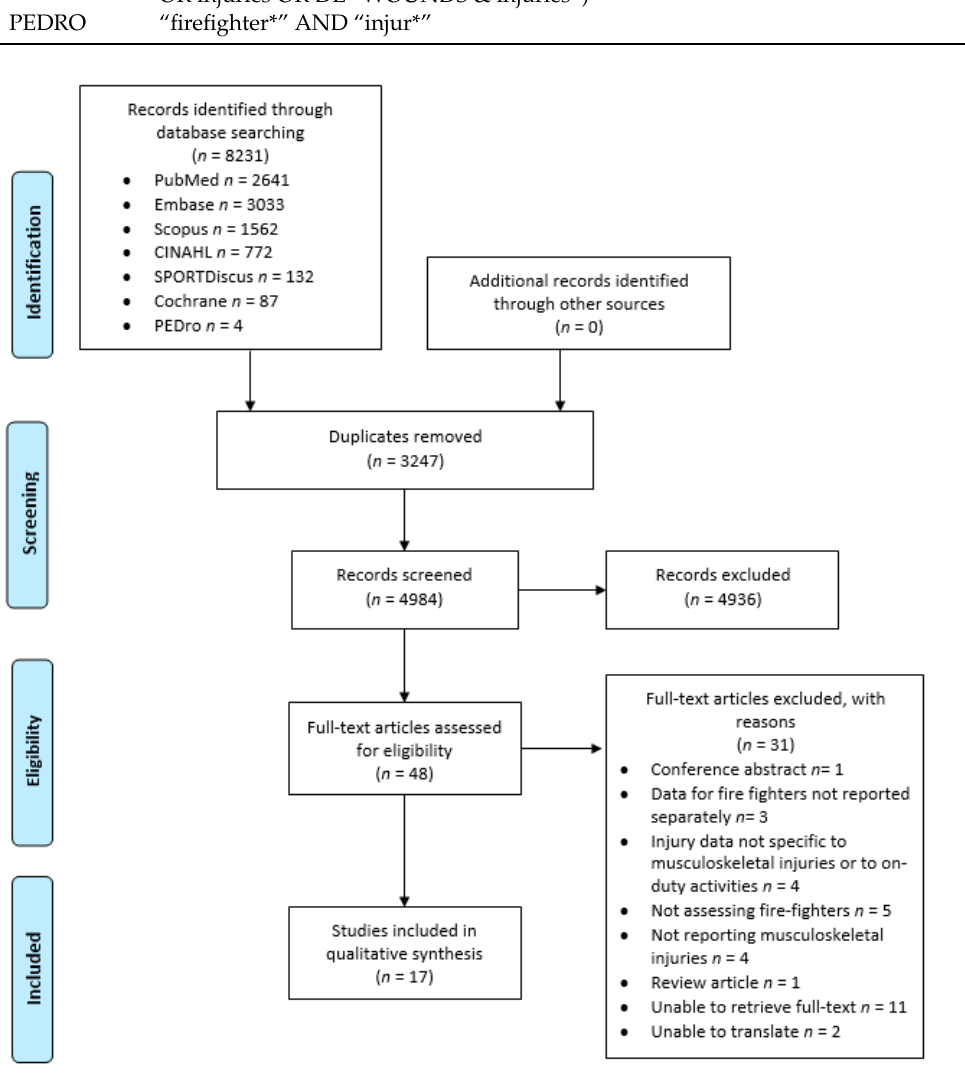
Figure 1. Preferred Reporting Items for Systematic Reviews and Meta-Analyses (PRISMA) flow diagram showing literature search, screening and eligibility results.